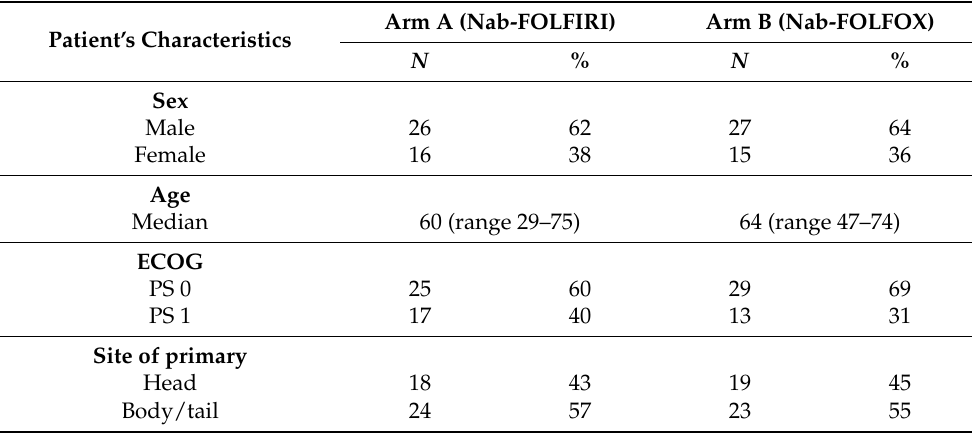
Table 3. Phase II: patient’s